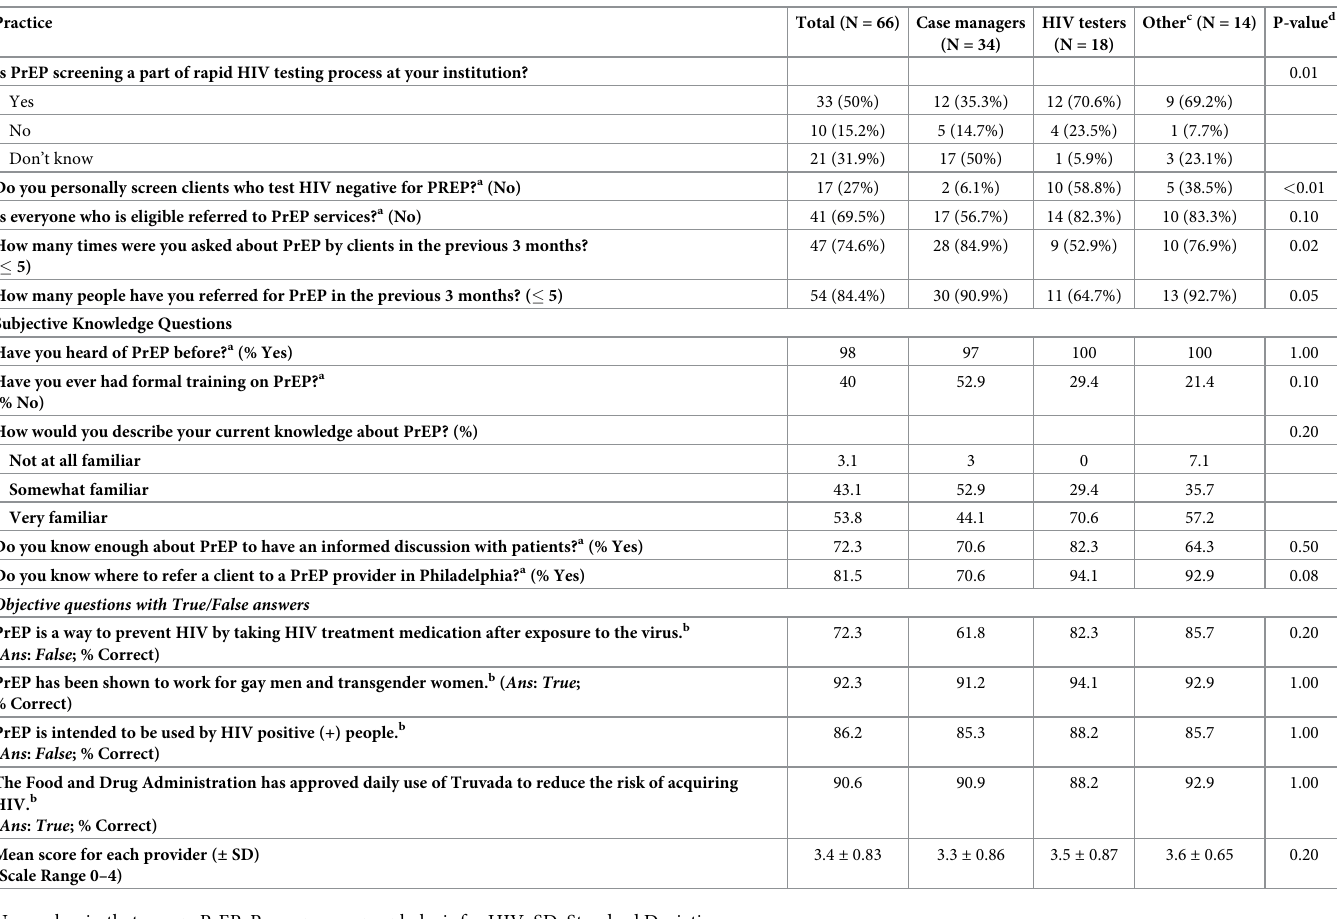
Table 2. Current referral practices and knowledge of non-prescribing providers in Philadelphia (N = 66).